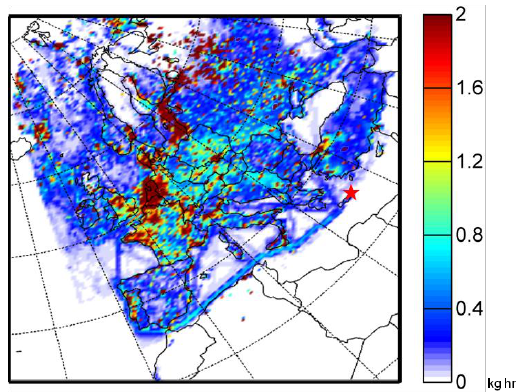
Figure 1. Hourly averaged primary organic aerosol bulk emissions for the European domain 935 during the EUCAARI period (May 2008). The red star indicates the location of the FAME-08 936 Fig. 1. Hourly averaged primary organic aerosol bulk emis- measurement site. 937 sions for the European domain during the EUCAARI period (May 938 2008). The red star indicates the location of the FAME-08 measurement